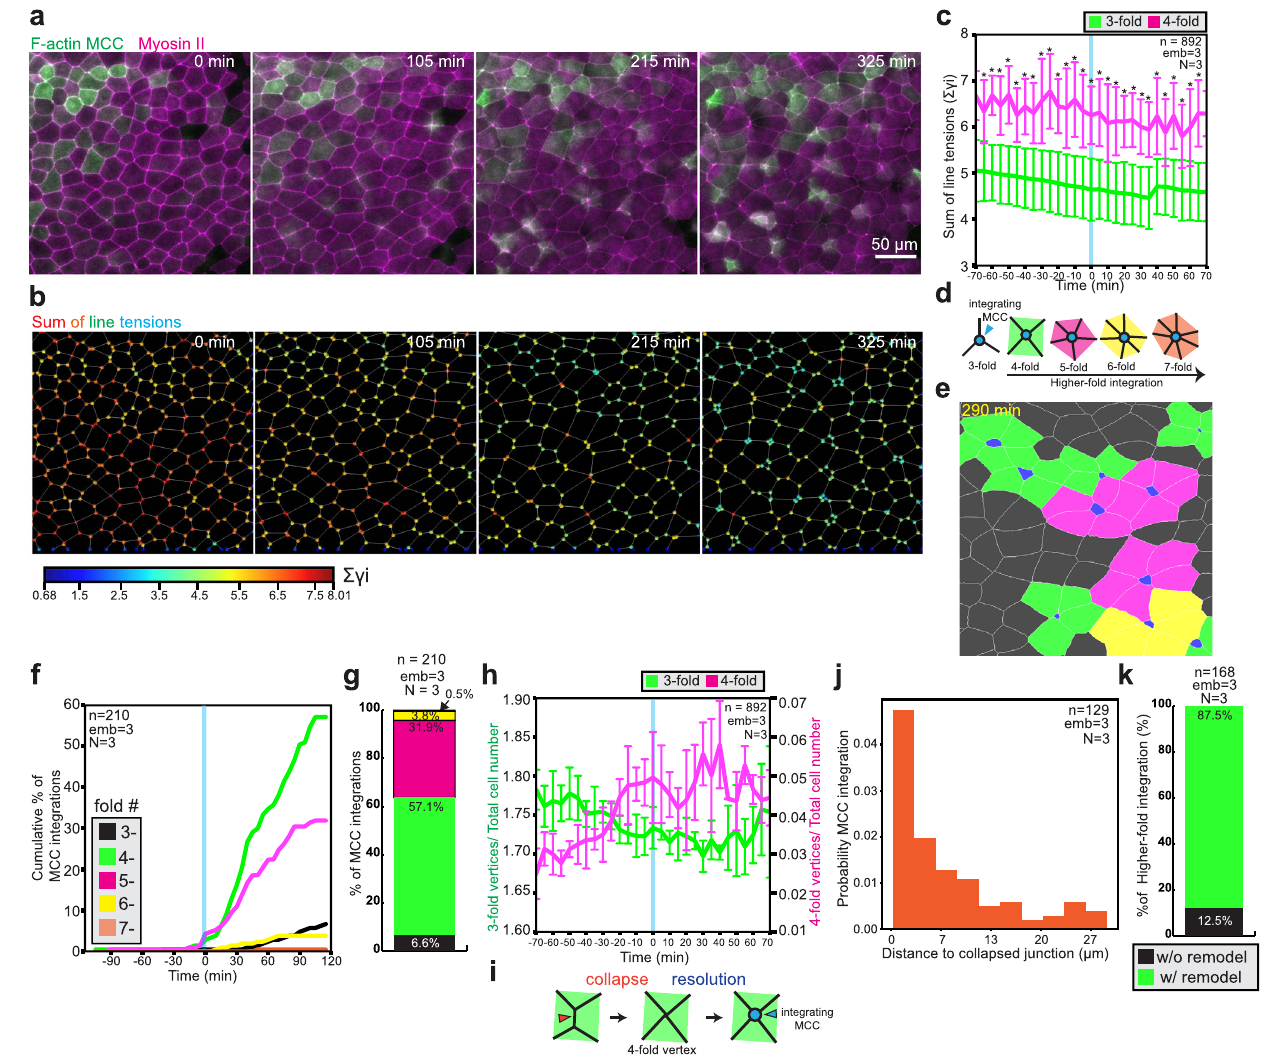
Fig. 4 | MCCs integrate at higher-fold, stiffer vertices. a Snapshots of super fi cial epithelium throughout MCC integration. MCCs and myosin II are labeled by expressing α -tubulin::LifeAct-RFP (pseudo-colored in green) and the myosin intrabody SF9-3xGFP (pseudo-colored in magenta), respectively. Scale bar: 50 μ m. b Sum of line tensions across time color-coded from low (blue) to high tensions (red) extracted from a . c Sum of line tensions for threefold vertices (green) and fourfold vertices (magenta) during MCC integration (from n =892 cells from 3 embryos, N =3 experiments). Data show mean±SD, asterisks represent signi fi cant statistical differences between datasets. Two-tailed Mann – Whitneytest * p =[2.00E − 13, 0.00176]. d – g Quanti fi cation of MCC integration according to the number of neighboringgobletcells. d Schematicsrepresentinghigher-foldintegrations,color- codedaccordingtothenumberofneighboringcells. e Segmentedimagedepicting higher-foldcellintegrations,color-codedaccordingto d .ApicallyexpandingMCCs